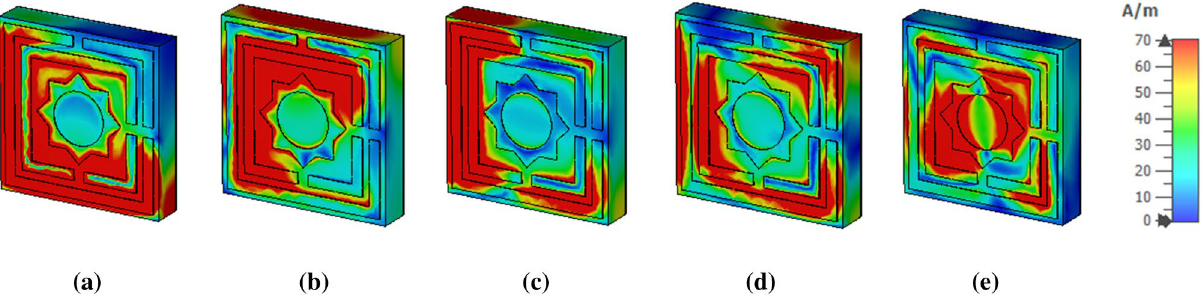
Figure 12. H field distribution of the MAA unit cell at ( a ) 3.80 GHz, ( b ) 5.65 GHz, ( c ) 8.45 GHz ( d ) 10.82 GHz and ( e ) 15.92 GHz.